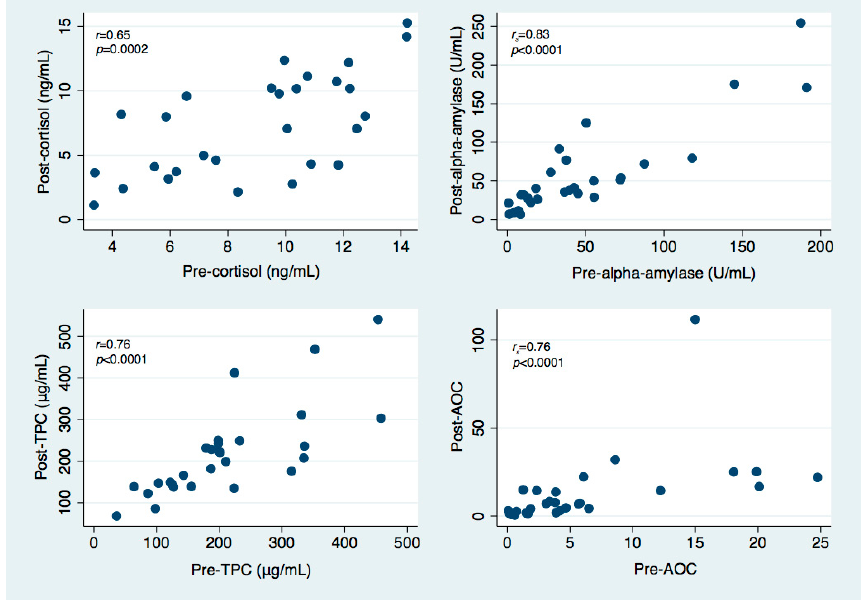
Figure 1. Scatter plots illustrating the relationship between pre-treatment and post-treatment levels of salivary cortisol, salivary alpha-amylase, total protein content (TPC) and salivary alpha-amylase over cortisol ratio (AOC).